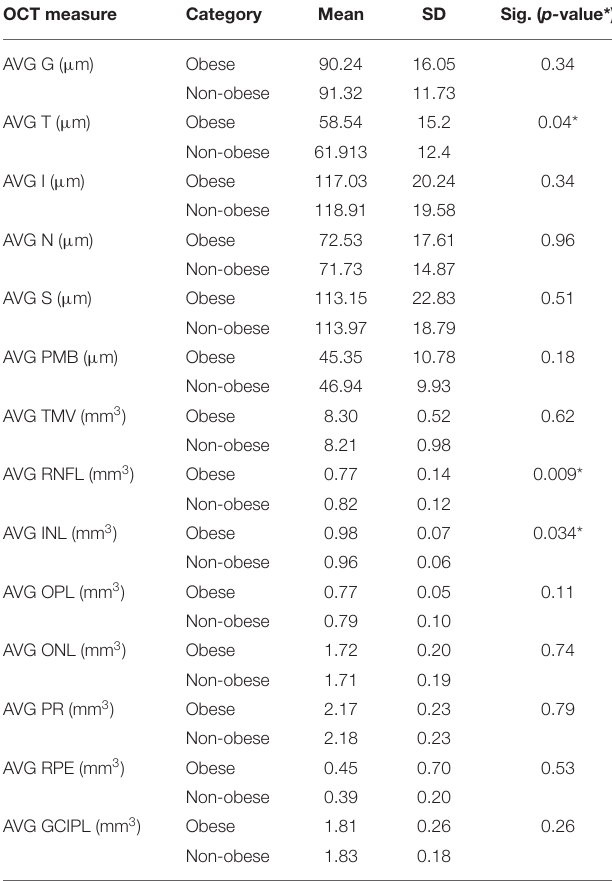
TABLE 3 | OCT outcome significance by category (obese vs.